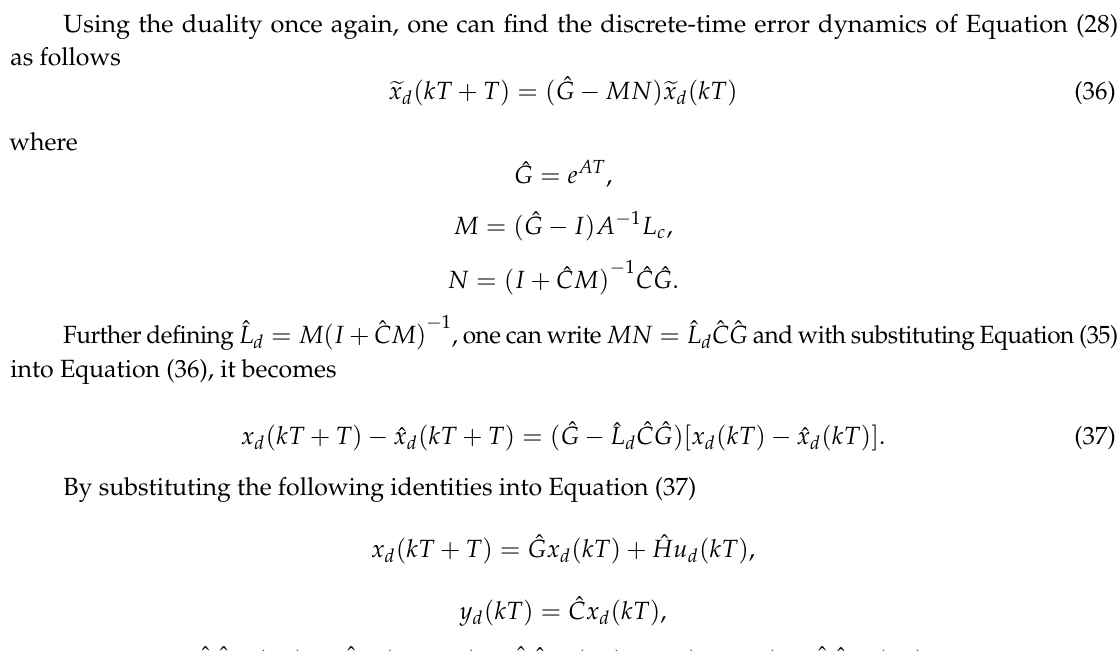
Figure 1. A continuous-time system with a full-order observer.